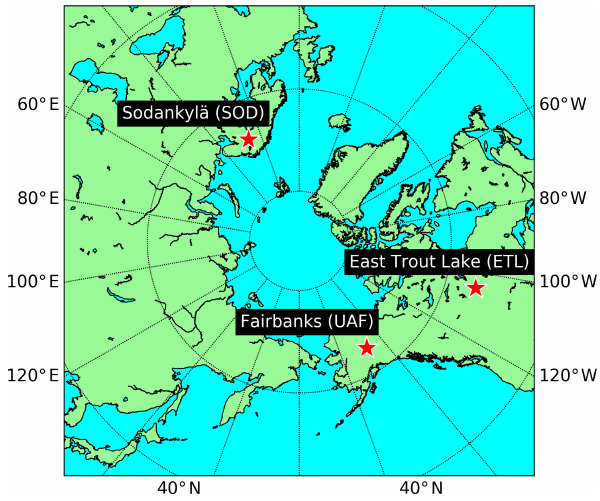
Figure 1. Circumpolar map showing locations of boreal forest sites included in this